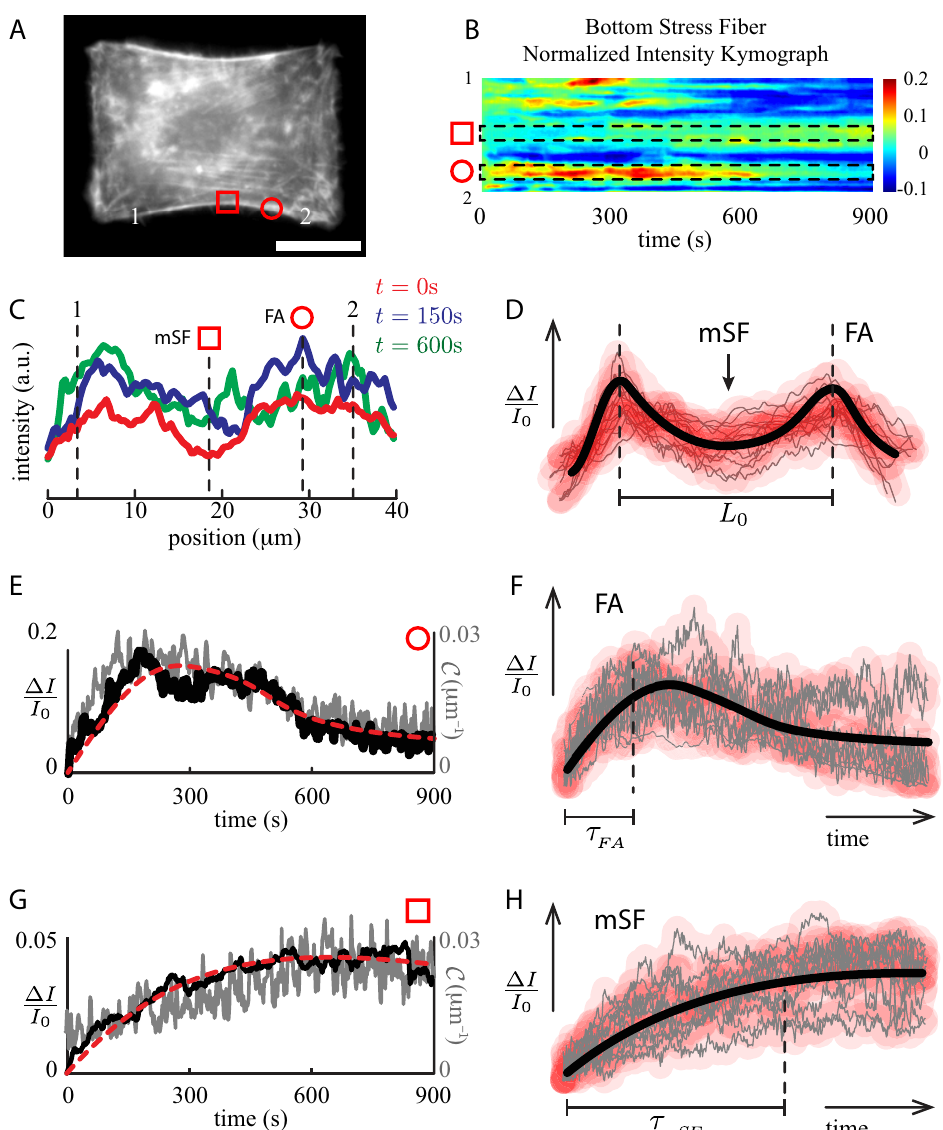
Figure 4. Local analysis of the F-actin intensity kymograph. ( A ) RPE-1 cell on H-like pattern at constant stretch ( (cid:101) ≈ 0.2). Scale bar 20 µ m. ( B ) Normalized relative intensity kymograph of the bottom SF (arc-segment 1–2) displays high activity at both ends of the SF, whereas a moderate intensity evolution at the middle section of the bundle. ( C ) Intensity profiles along the bottom SF for t = 0 s (blue solid line), t = 150 s (red solid line) and t = 600 s (green solid line), respectively. The red square identifies the SF minimum intensity (mSF), whereas the red circle shows the highest F-actin intensity location (FA). ( D ) F-Actin intensity profile of 14 SFs, where the thick continuous black line represents a sketch of the F-actin bundle, with two focal adhesion sites (FAs) and a valley at the middle section of the SF (mSF). ( E ) Normalized intensity evolution of the bottom SF computed from the kymograph at the FA region (red circle), whereas ( G ) displays the evolution at the mSF region (red square). In both cases, the local curvature is shown (gray solid line). Mechanical parameter values were obtained from best fits (red segmented lines) computed using the intensity data and Equation (10). ( F , H ) Intensity evolution of 14 FAs and 12 mSFs locations at constant stretch. The thick continuous black line represents a sketch of the intensity evolution at these